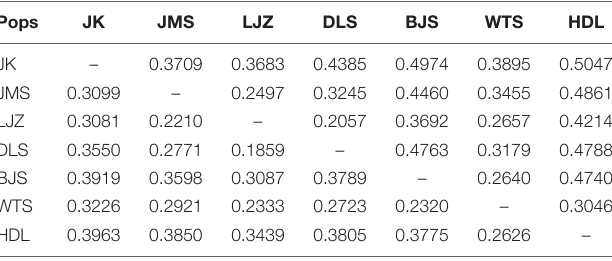
TABLE 2 | Genetic differentiation coefficient ( F ST ) and Reynolds genetic distance (DR) among